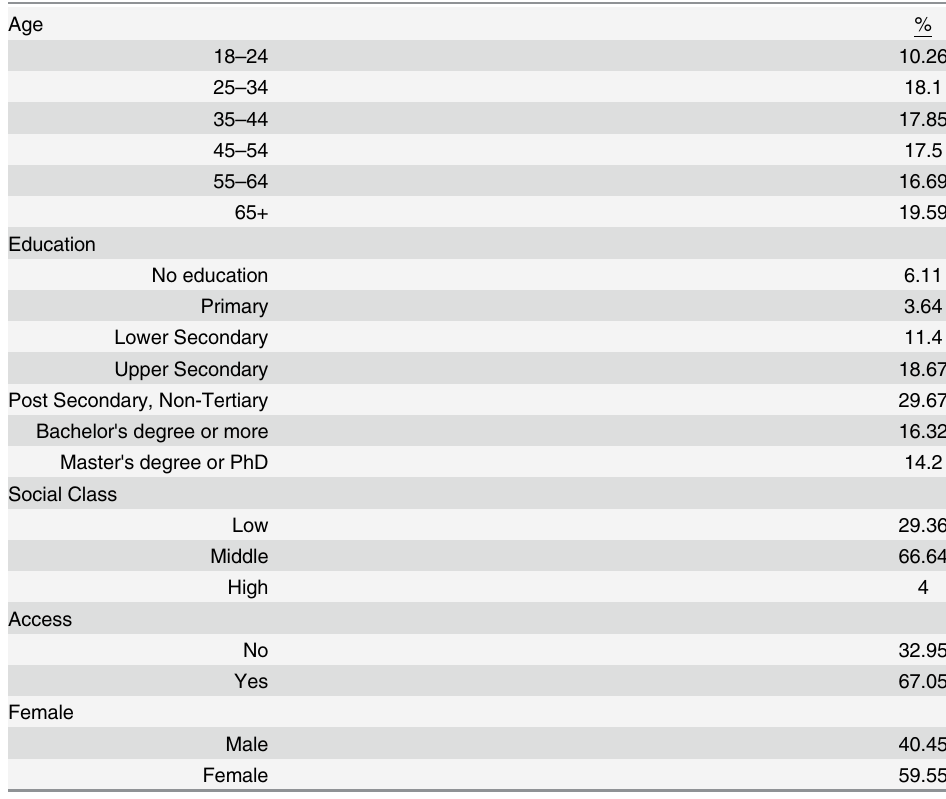
Table 4. Percent distribution of control